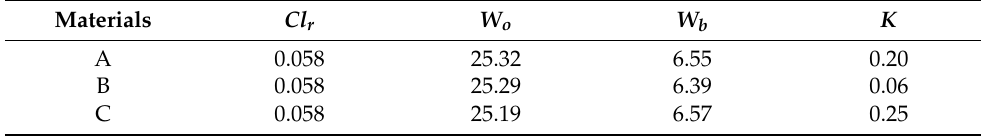
Table 4. The calculated fluidity coefficient K of the clad material of the experimental